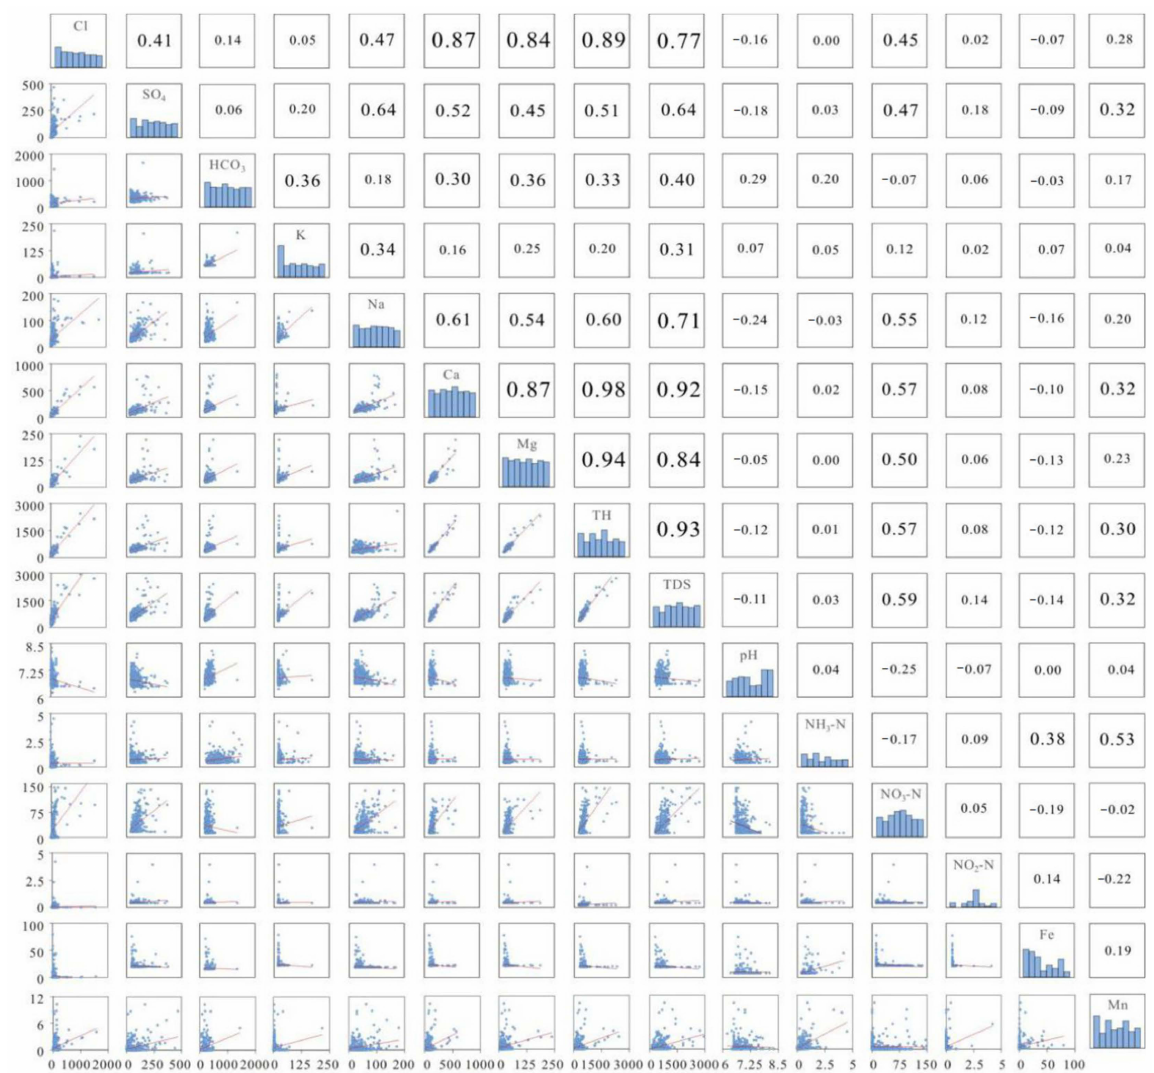
Figure 6. Relationships between different chemical parameters and histogram of each parameter’s annual average